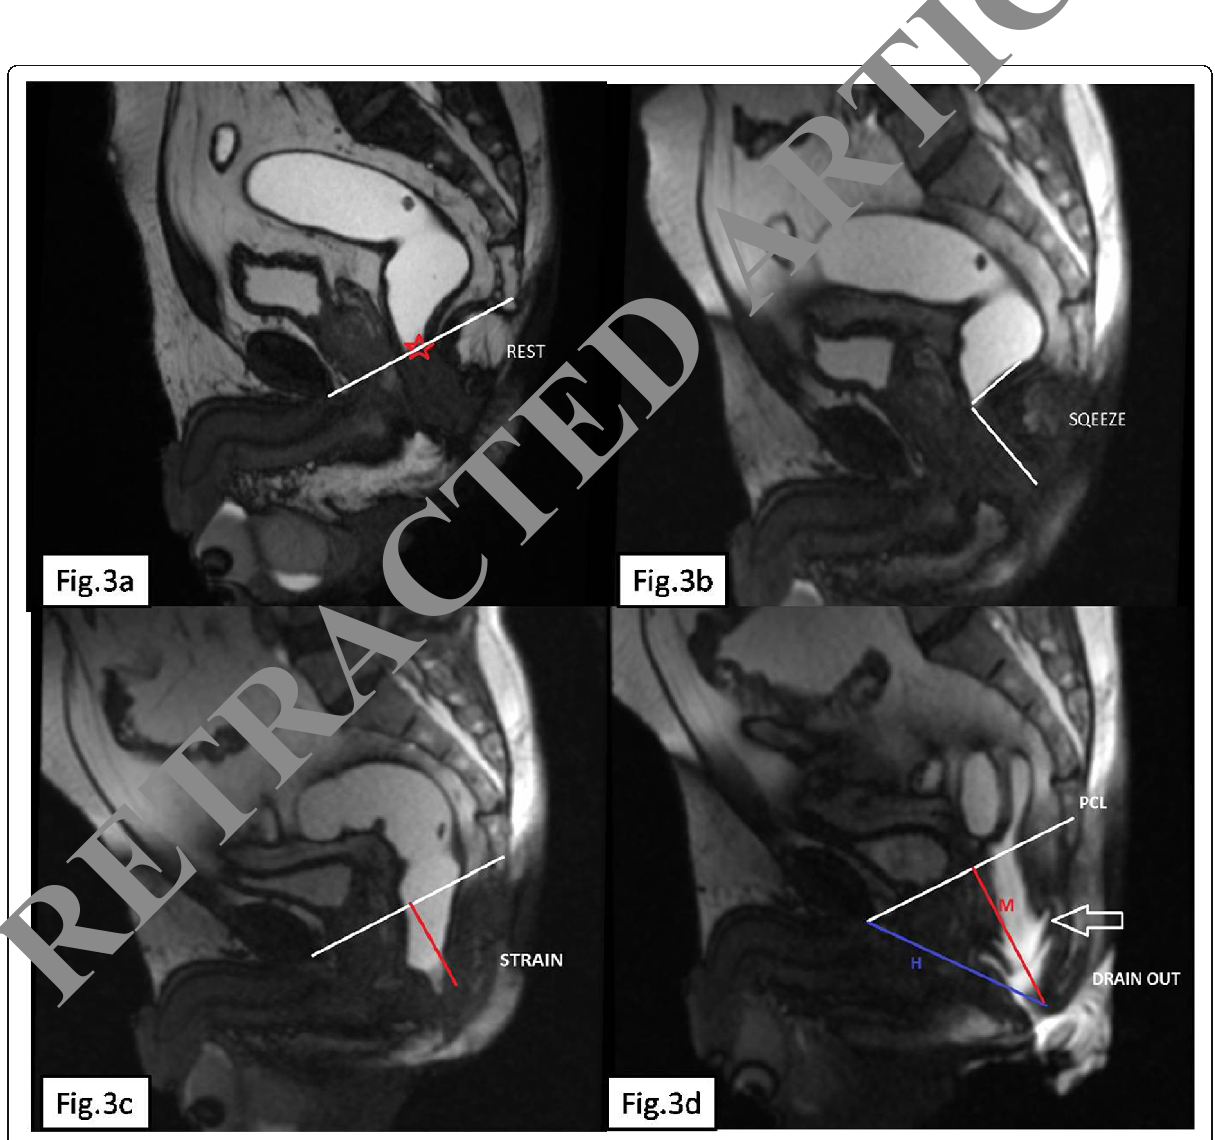
Fig. 3 Ano-rectal junction descent with rectal intussusception. During rest, ano-rectal junction (red star) is at the level of PCL ( a ). During squeeze ( b ), there is slight decrease in ano-rectal angle. During strain, ano-rectal junction (red line) shows a descent of 4.2 cm ( c ). During the defecation phase, there is further descent of ano-rectal junction (red line) with rectal intussusception (white arrow in d